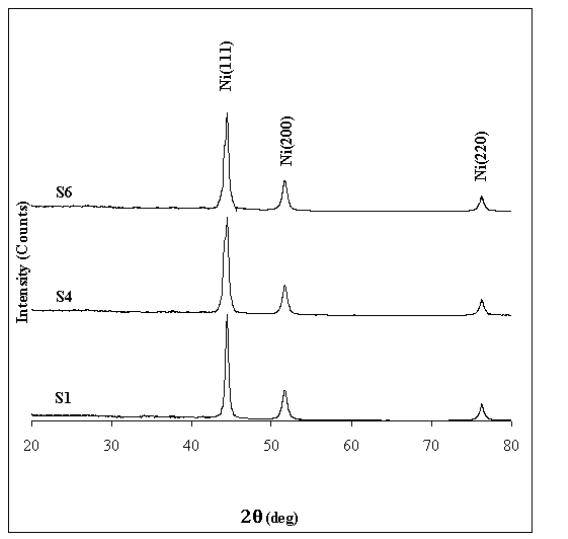
Figure 4. XRD patterns of S